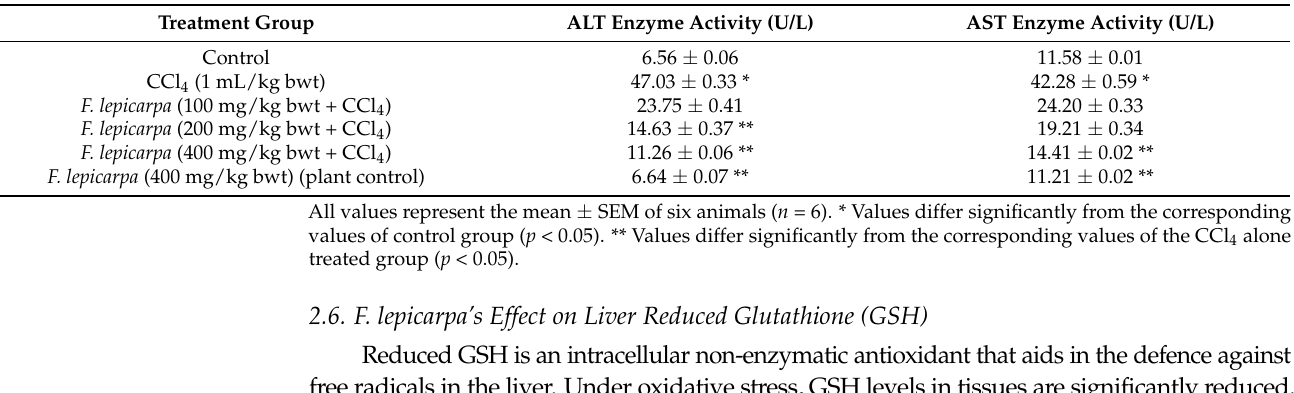
Table 4. Effects of F. lepicarpa on hepatic serum AST & ALT levels following CCl 4 treatment.